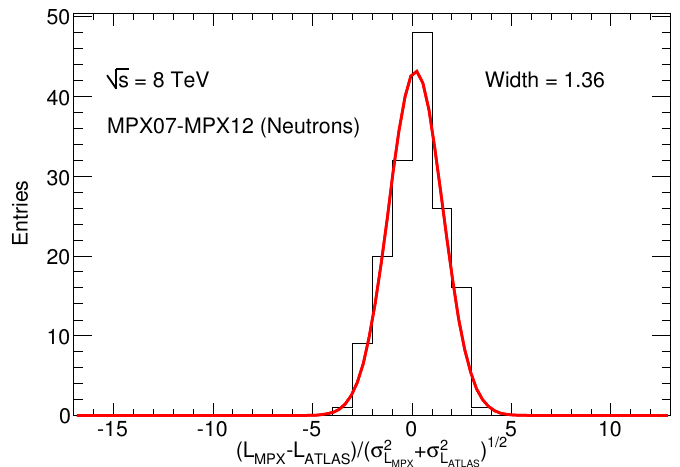
+ σ 2 ) 1/2 , where σ L MPX is the statistical L MPX L ATLAS the run-by-run uncertainty on the ATLAS ATLAS